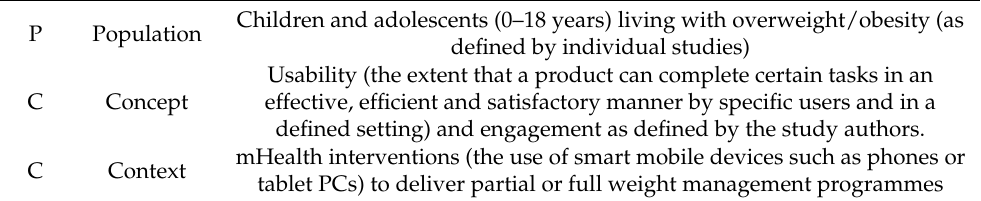
Table 1. PCC outline to develop search protocol for literature